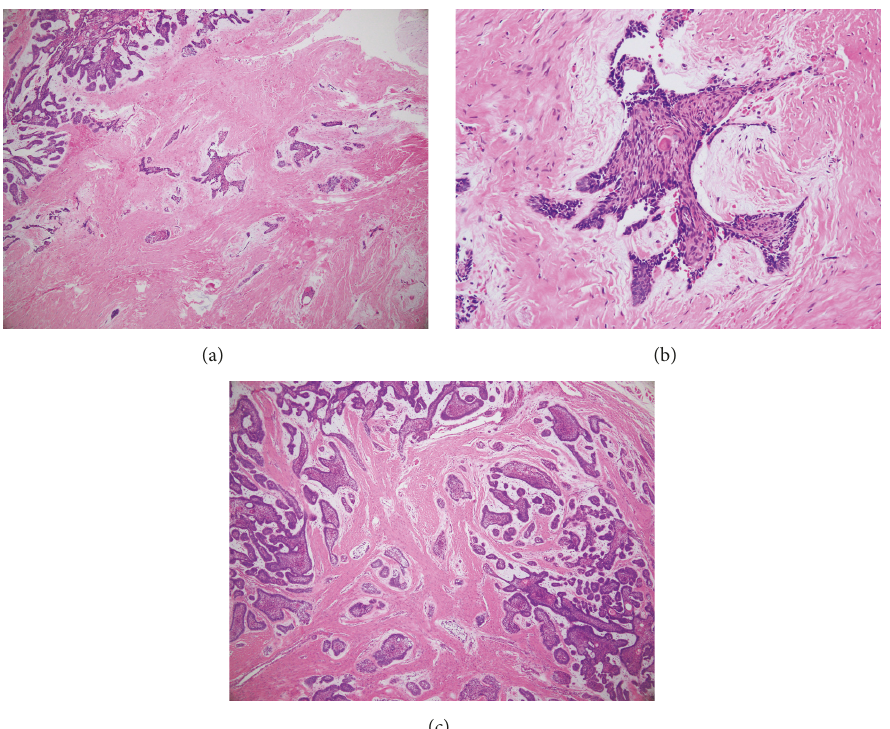
Figure 5: (a) A histopathological image showing a mixture of follicular and desmoplastic ameloblastoma. ( × 10) (b) A histopathological image showing stellate-shaped epithelial islands together with squamous metaplasia in the collagenized fibrous stroma containing connective tissue. ( × 40) (c) A histopathological image showing typical follicular ameloblastoma together with cystic degeneration and squamous metaplasia ( × 40).